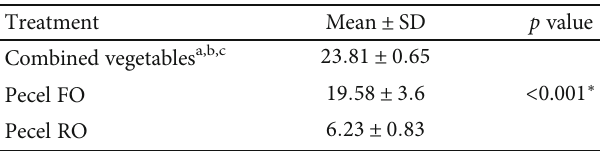
Table 4: Inhibition of lipid peroxidation by combined cooked Pecel vegetables with or without peanut